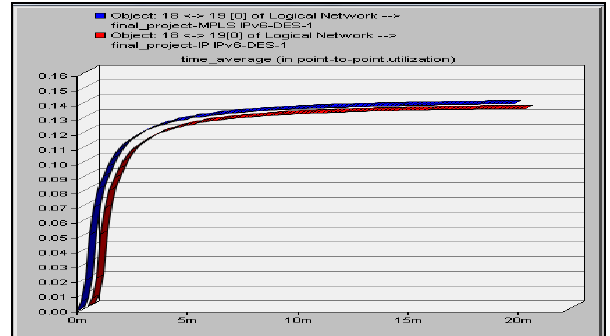
Figure 27 Link Utilization Comparison of 27 to 28